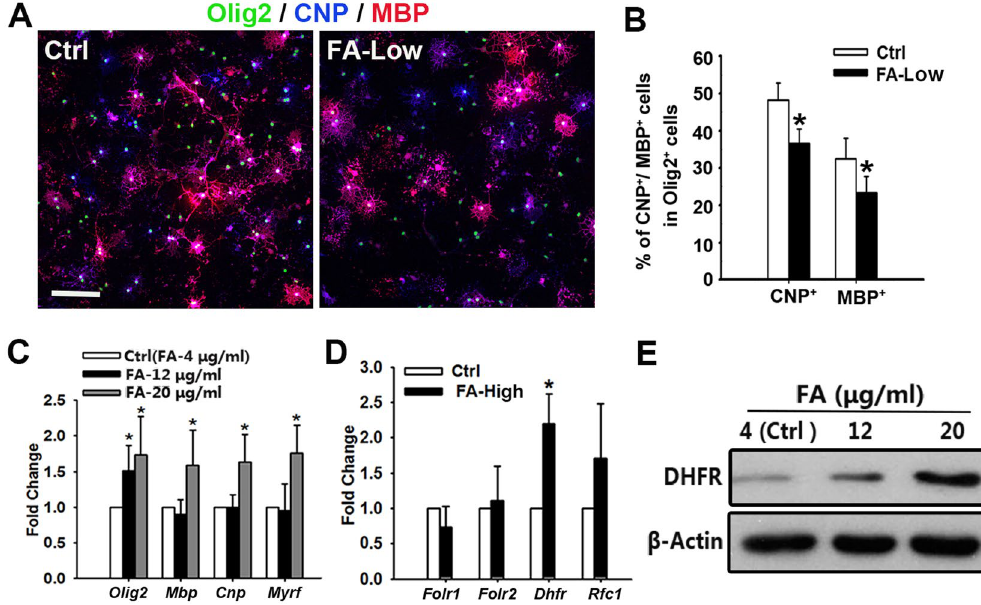
Figure 2. Folate promotes oligodendrocyte maturation depending on DHFR activation in vitro . ( A ) Rat cortical oligodendrocyte precursors (OPCs) from pups at P2 isolated and cultured with different concentrations of folate (Ctrl: folate 4 μ g/ml, FA-Low: folate 0.02 μ g/ml) for 3 days stained with Olig2, CNP and MBP antibodies. ( B ) Quantification of the percentage of CNP + or MBP + cells among Olig2 + cells in ( A ) are shown in ( B ). Data represents the mean ± S.D. (n = 5, * p < 0 . 05 , student’s t test). ( C ) qRT-PCR analysis of oligodendrocyte and myelin associated genes and proteins expression after folate treatment for 48 h in Oli-neu cells. Data represents the mean ± S.D. (n > 3, * p < 0 . 05 compared with control, student’s t test). ( D ) qRT-PCR analysis of folate metabolism associated genes expression from spinal cords of control and FA-High mice at P3. Data represents the mean ± S.D. (n > 3, * p < 0 . 05 compared with control, student’s t test). ( E ) Western blot analysis of DHFR (20 kDa) expression in the spinal cord of control and MTX (4 mg/kg)-treated mice. β -actin (43 kDa) is the loading control. Scale bars: 100 μ m ( A